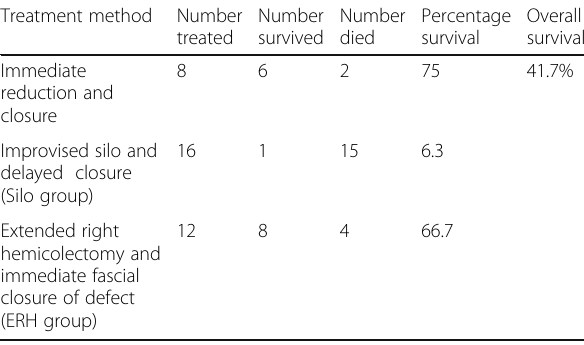
Table 3 Outcome of management of gastroschisis Treatment method Number